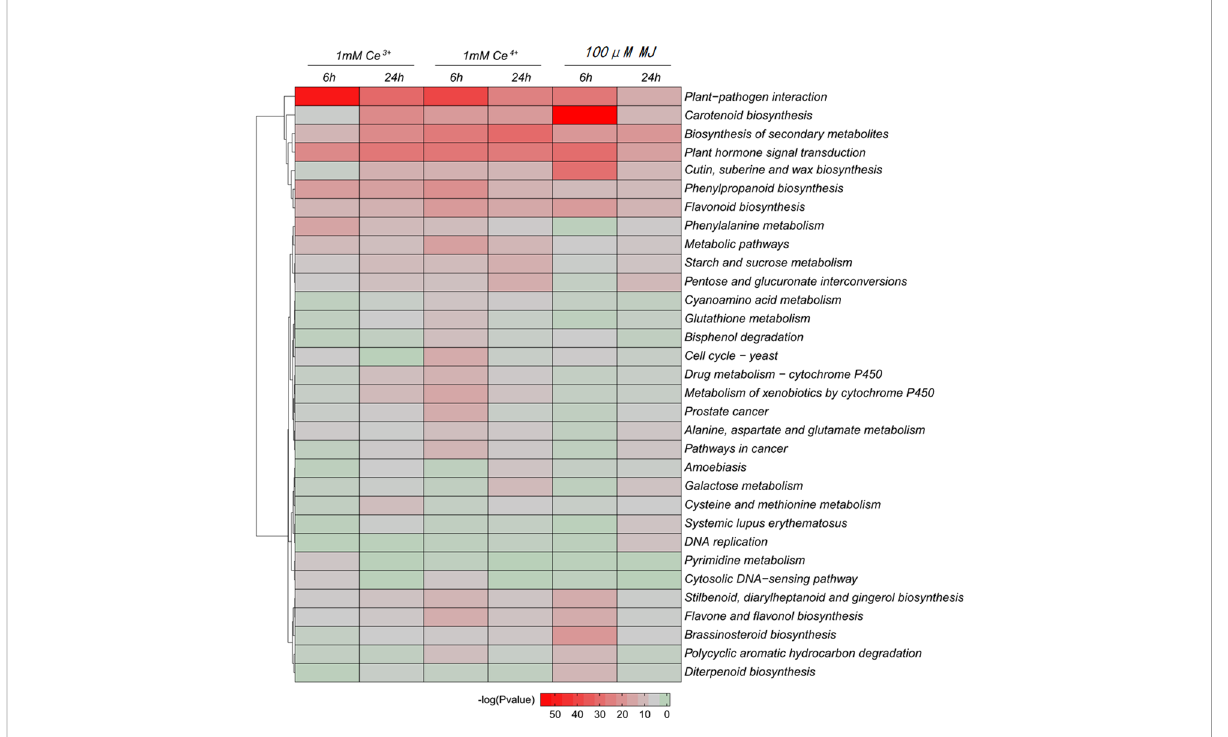
FIGURE 4 KEGG enrichment analysis of the DEGs in the six comparisons. The color indicates the signi fi cance level.